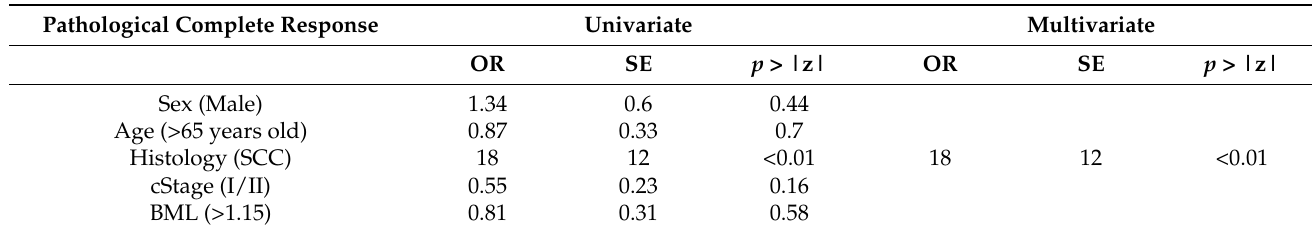
Table 4. Logistic regression. Univariate and multivariate analysis for pathological response to neoadjuvant chemoradiotherapy. SCC: Squamous cell carcinoma; SE: Standard error; bone marrow- to-liver SUV ratio (BML).